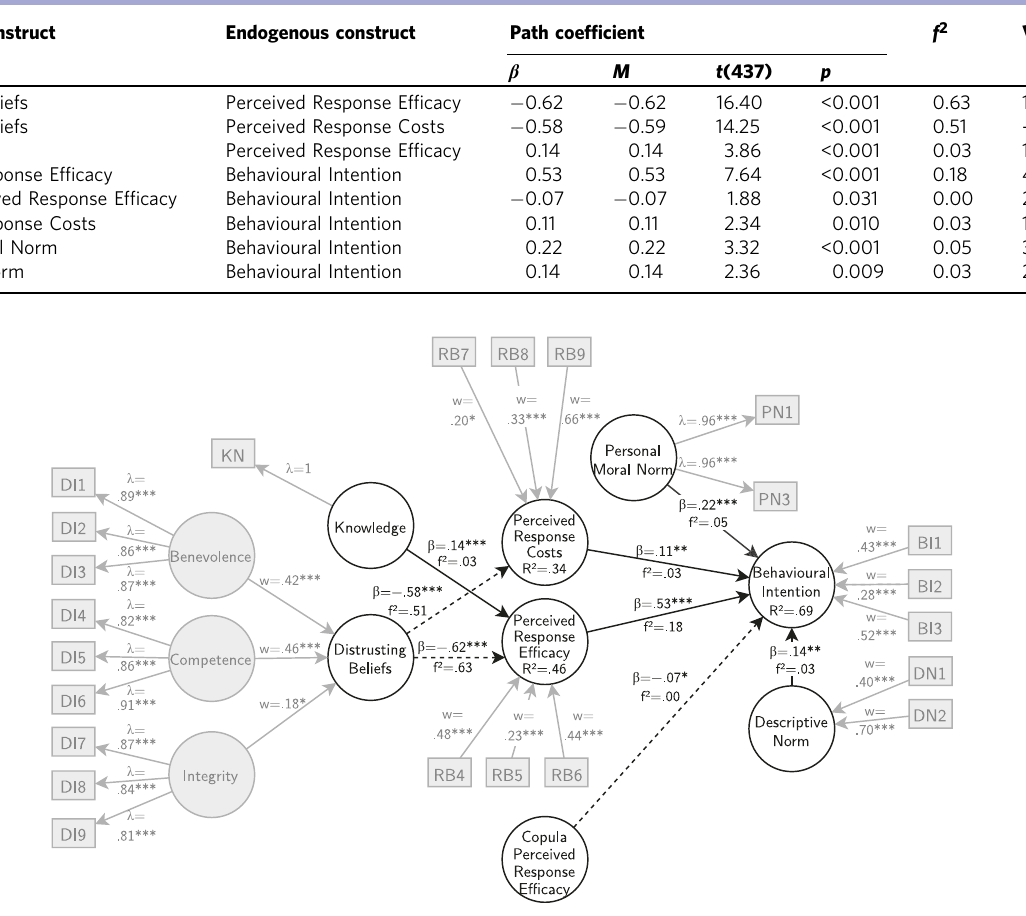
Fig. 4 Final structural equation model. Shown are original estimate loadings λ , weights w, and path coef fi cients β (* p < 0.05, ** p < 0.01, *** p < 0.001), effect sizes f 2 and explained variance R 2 ; Dashed paths signify a negative path coef fi